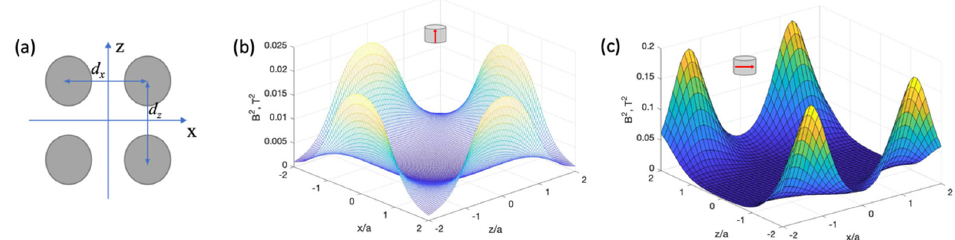
Figure 12. ( a ) Schematic configuration of a unit cell of arrays of cylindrical micromagnets. ( b , c ) Two- dimensional plots of the energy profile (per unit cell) represented by the square of the magnetic field induction ( B 2 ) from arrays of cylindrical micromagnets with axial and diametric magnetisations, respectively, in the x-z plane. y / a = 0.7. The magnet parameters correspond to Co-based amorphous alloys with magnetisation µ 0 M = 0.6 T , radius a = 15 µ m, length 2 L = 2 a , and distance between magnets d x = d z = 2.5 a .